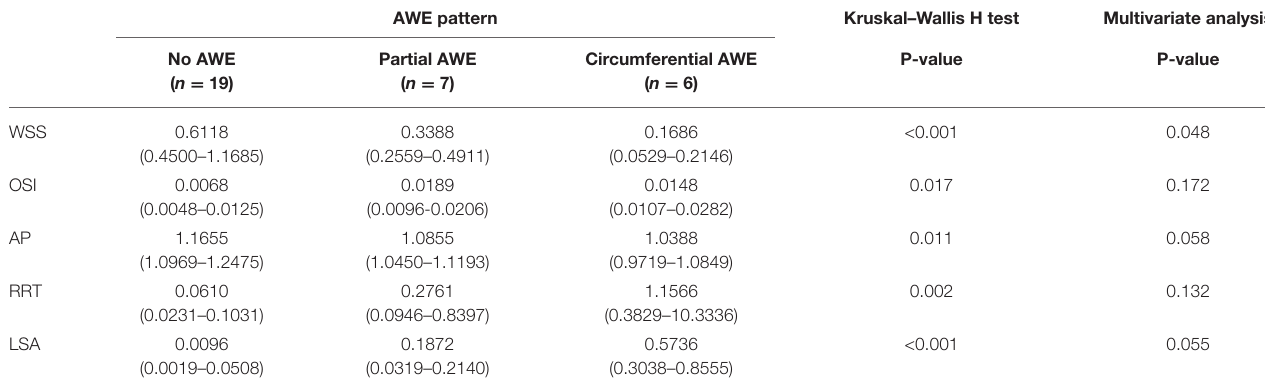
TABLE 2 | The hemodynamic characteristics of unruptured intracranial aneurysms with different aneurysm wall enhancement (AWE)